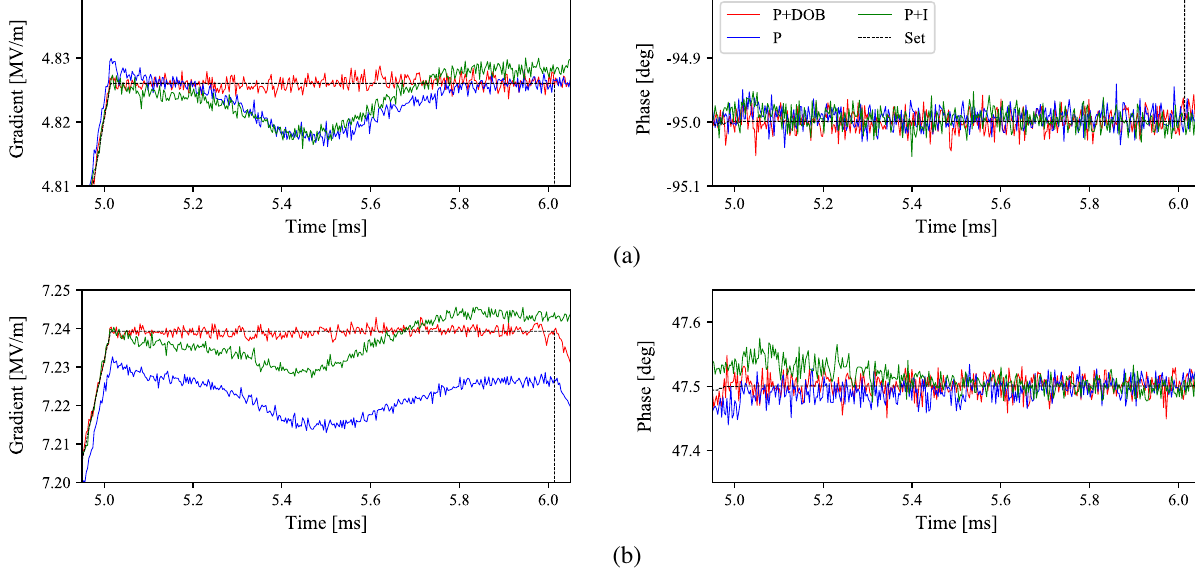
FIG. 22. P control (blue) versus PI control (green) versus P þ DOB control (red) on ML1 and ML2 in the presence of long pulse beam. (a) Amplitude and phase stabilities during the flat-top of the pulse rf on ML1 at 5 MV. (b) Amplitude and phase stabilities during the flat- top of the pulse rf on ML2 at 7.5 MV. The f Q in the DOB controller is selected to be 7.5 kHz to reach a